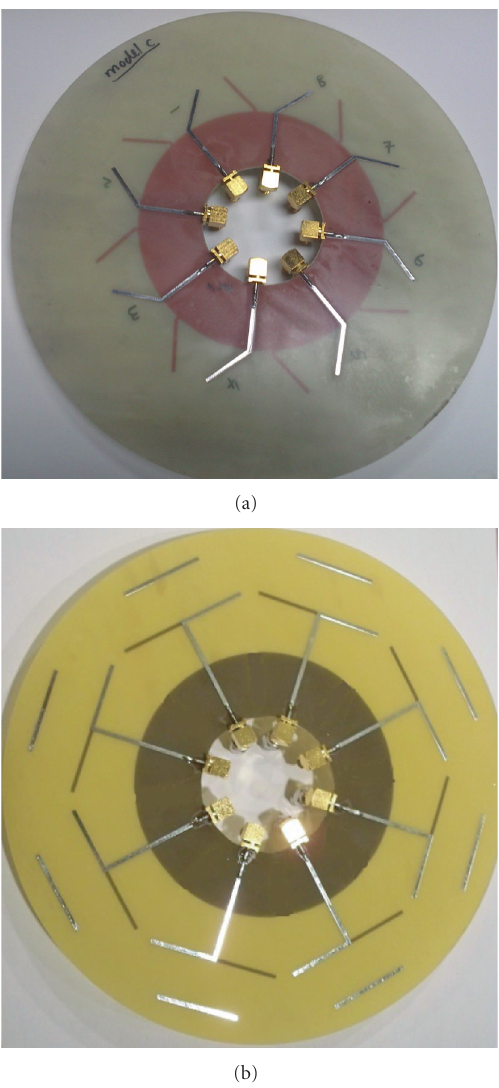
Figure 3: Fabricated printed antenna arrays: (a) 8-element V- shaped circular array and (b) 8-element Yagi circular array.